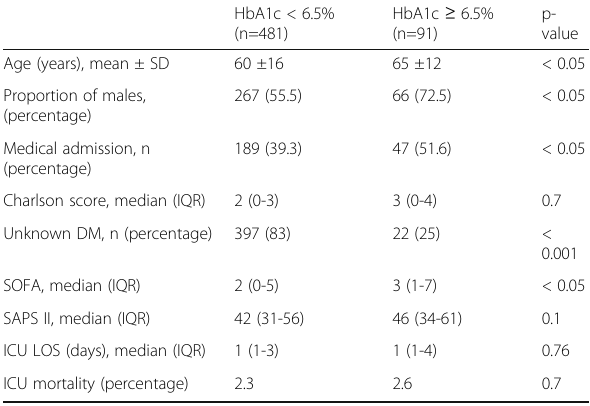
Table 1 (abstract 0114). Summary of